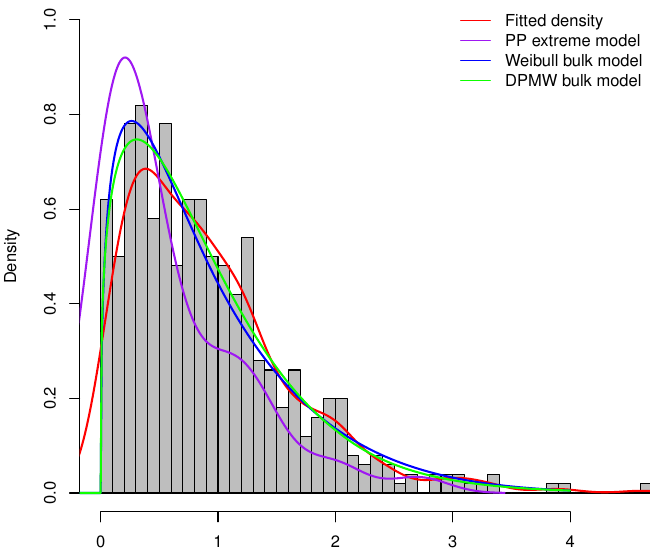
Figure 8. The posterior density plot for three models (the DPMW-PPR model, the PP extreme value model and the WMPP extreme model) with n = 1000. The red line shows the true density function, the green line, the blue line and the purple line are the posterior density function of the DPMW-PPR model, the WMPP extreme model and the PP extreme value model,